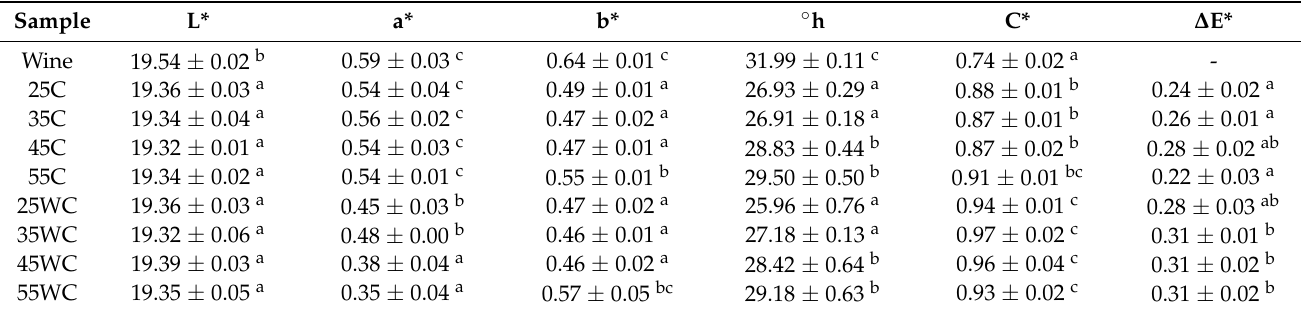
Significant differences ( p < 0.05) between samples are indicated by different superscript letters within the column (ANOVA. Fisher’s LSD